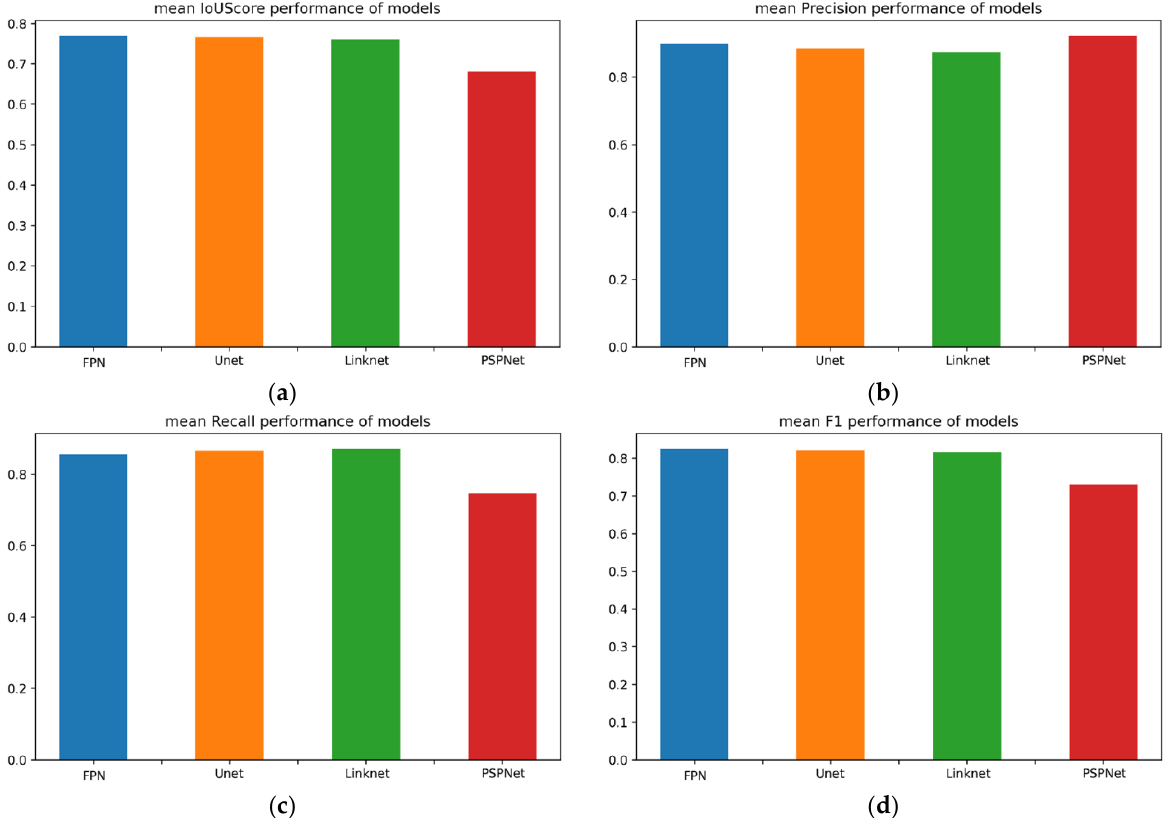
Figure 11. ( a ) Mean IoU score performance of all models; ( b ) mean precision performance of all models; ( c ) mean recall performance of all models; ( d ) mean F1 score performance of all models.